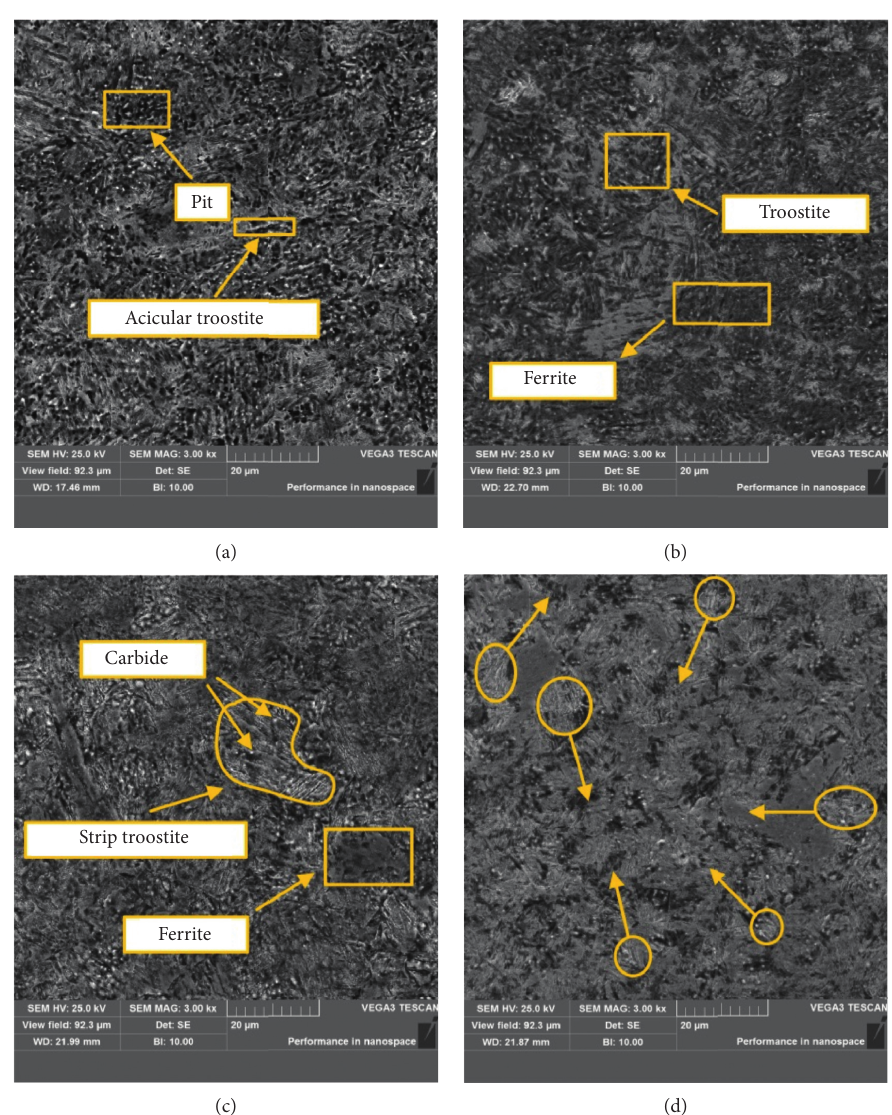
Figure 6: SEM images of process groups (3.00 kx): (a) UT, (b) HT, (c) DCT, (d)